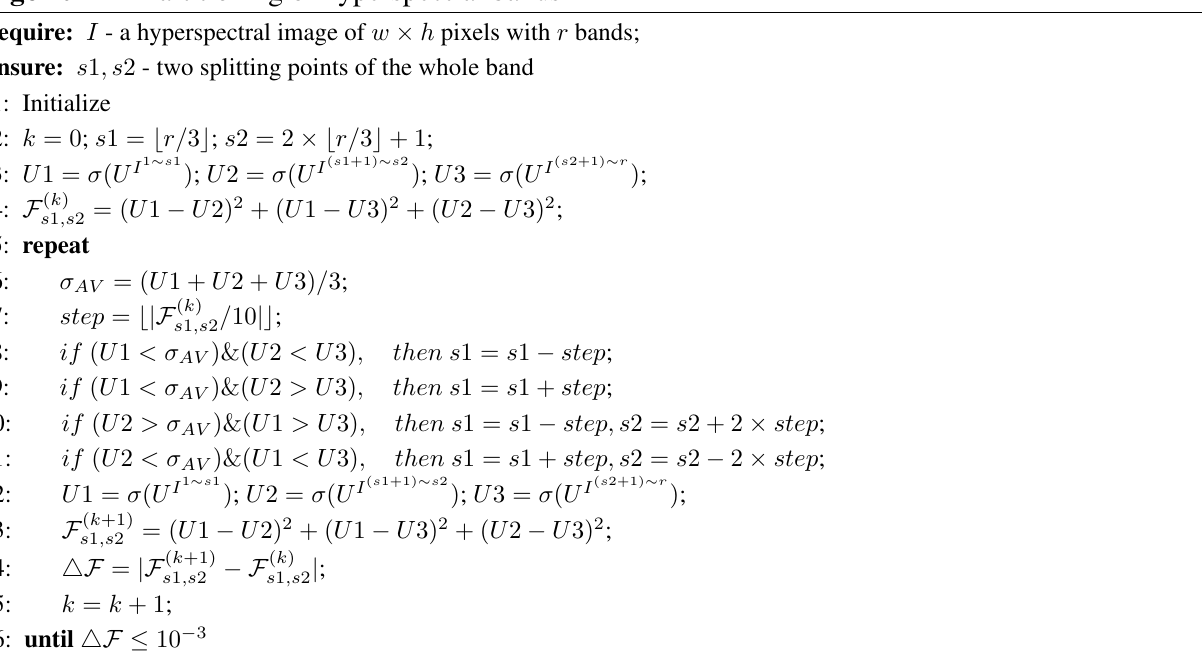
Algorithm 1 Partitioning of hyperspectral